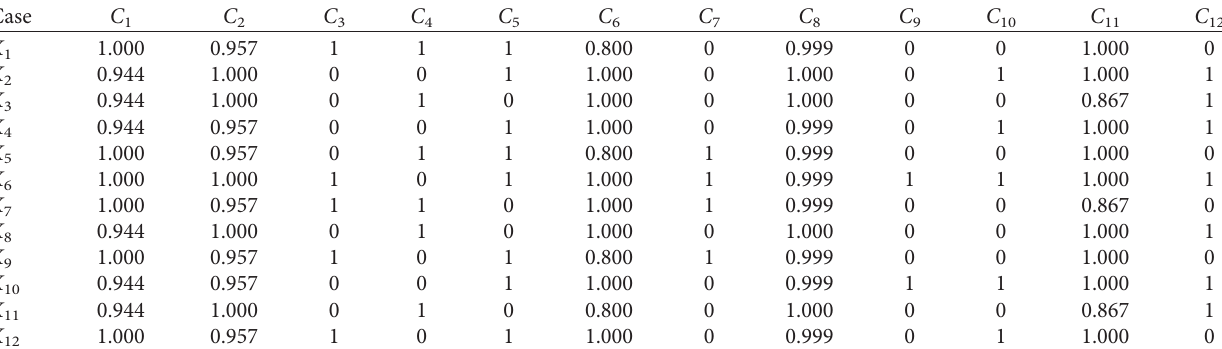
Table 3: Attribute-based case